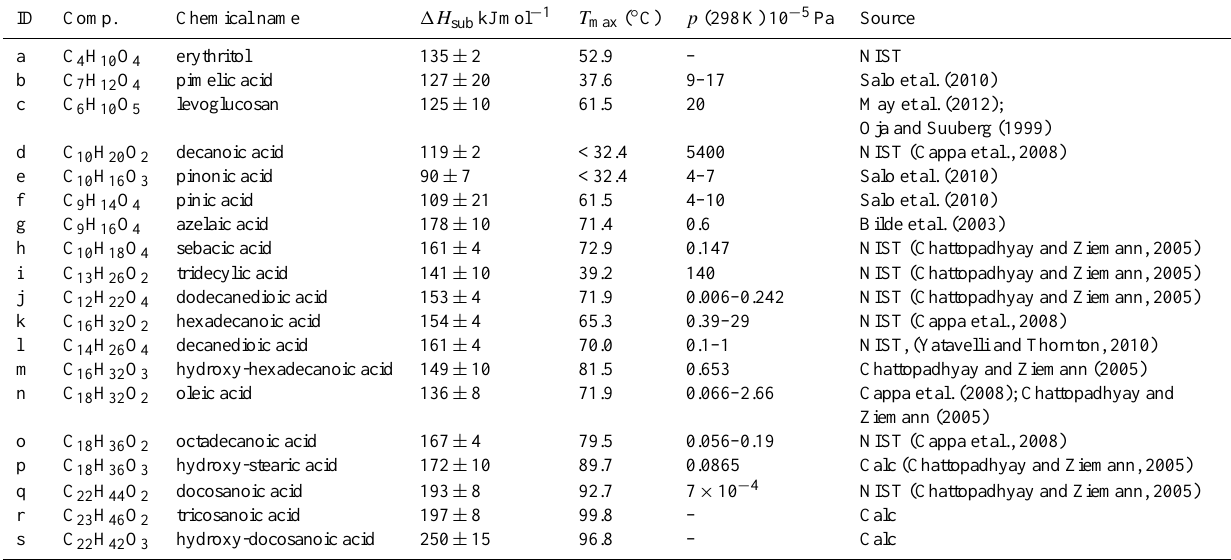
Table 2. Compounds used to determine the relationship between 1H sub and maximum desorption temperature. Literature values were obtained from the NIST database (Chickos, 2013) or the source referenced in the table. The letters correspond to the labeled points in Fig. 6. Compounds were manually deposited on the FIGAERO primary filter and subsequently desorbed. Calculated values follow (Capouet and Müller, 2006) for evaluating the group contribution change in vapor pressure and therefore 1H sub from known compounds. For hydroxy- acids the hydroxy group was added to calculate 1H sub